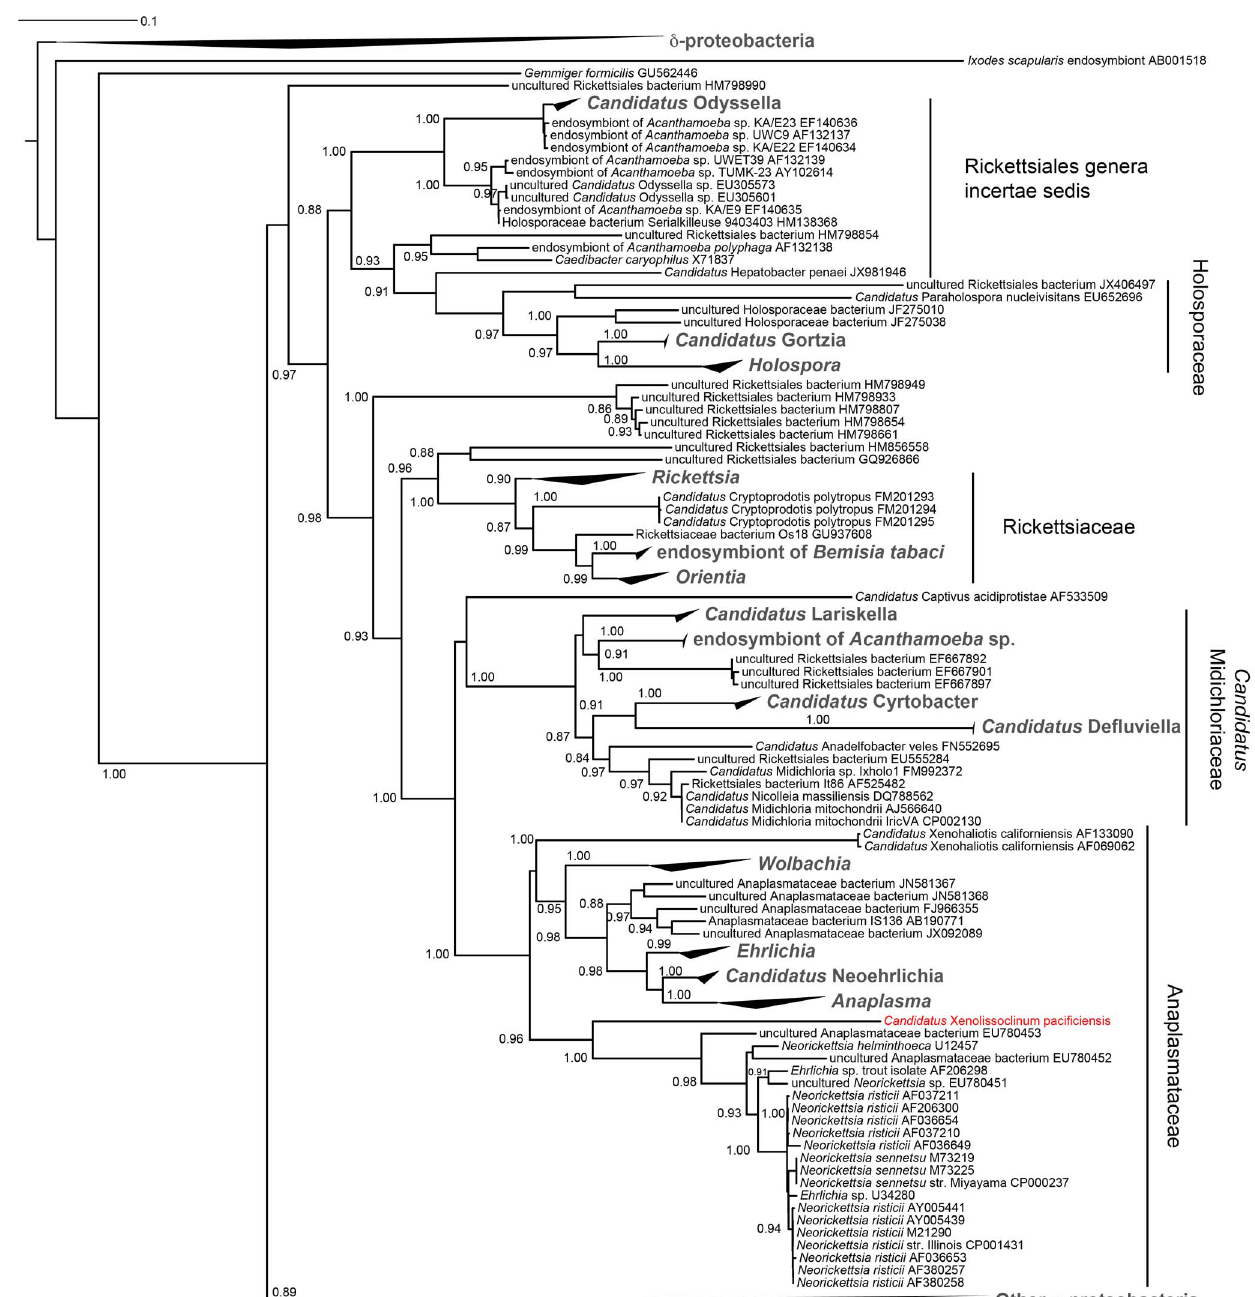
Figure 13. Ca. X. pacificiensis is a divergent member of the Anaplasmataceae family of the order Rickettsiales. The phylogenetic tree is based on 16S rRNA gene sequences, showing the Rickettsiales expanded, with the position of Ca. X. pacificiensis highlighted in red. Select d - proteobacteria are included as an outgroup. doi:10.1371/journal.pone.0080822.g013 manually normalized so that the maximum value was the same Divergence Comparisons (Figure 6) perpendicular distance from the x -axis in Adobe Illustrator. The Protein coding genes of the bacterial genomes were extracted accession numbers of the genomes used were: Buchnera aphidicola from GenBank files using a Perl script (genbank_multi_process.pl, Text S4). Homologous genes in the strain pairs were determined as with Ca. E. faulkneri L2/L5/BAL199, described above. The % identities for each homolog pair were tabulated and imported into R, where the distribution of identities was plotted as a density plot with the ggplot2 package. Plots were exported as SVG files and